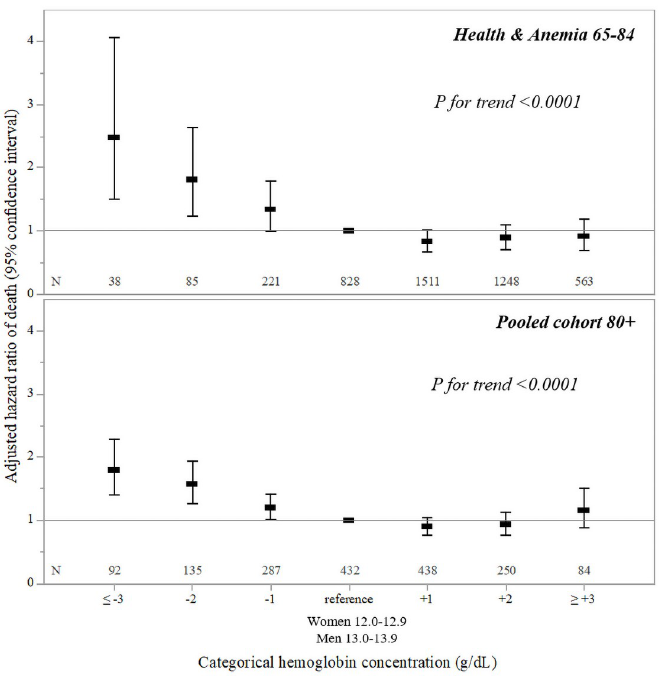
Fig 2. Association between categorical hemoglobin concentration and 7-year mortality risk in the Health & Anemia 65–84 cohort and in the pooled Health & Anemia 85+ and Monzino 80+ cohort. Hazard ratios adjusted for age, sex, education, smoking status, alcohol use, hospitalization (previous year), hypertension, diabetes, heart failure, myocardial infraction, TIA, stroke, chronic respiratory failure, chronic renal insufficiency, cancer, parkinsonism, dementia, study (only for pooled cohort 80+).